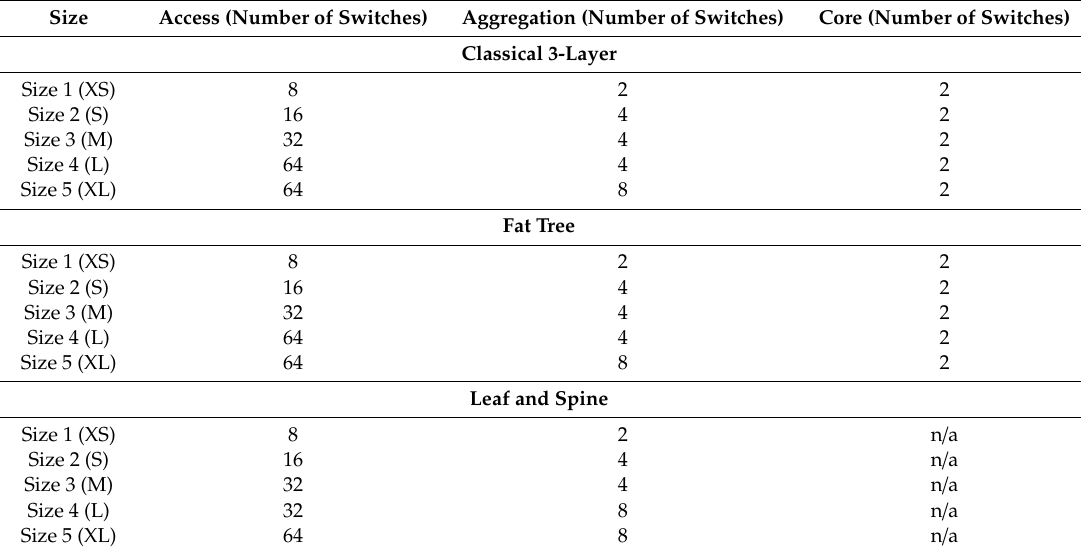
Table 2. Number of devices on evaluated